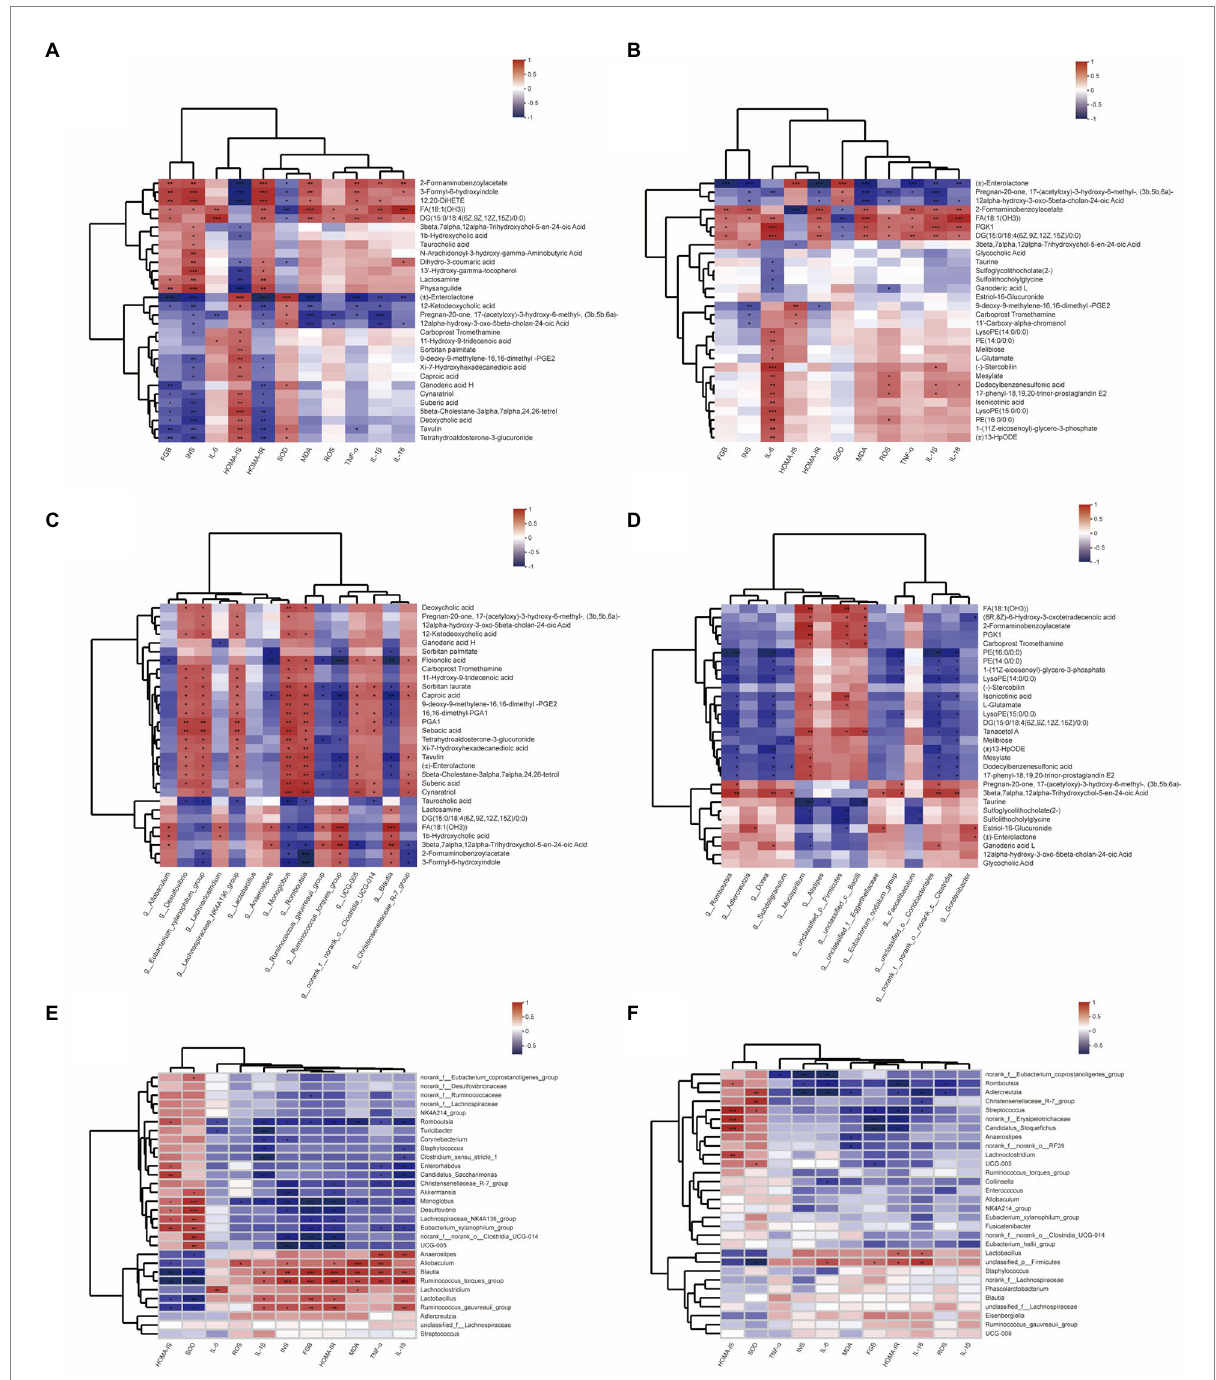
FIGURE 7 Heatmap of relationships between biochemical indexes, metabolites, and gut microbiota. (A) Relationship between biological indicators and the top 30 differential metabolites in control and model group. (B) Relationship between biological indicators and the top 30 differential metabolites in model and DBD group. (C) Relationship between top 15 differential gut microbiota and the top 30 differential metabolites in control and model group. (D) Relationship between top 15 differential gut microbiota and the top 30 differential metabolites in model and DBD group. (E) Relationship between biological indicators and the top 15 differential gut microbiota in control and model group. (F) Relationship between biological indicators and the top 15 differential gut microbiota in model and DBD